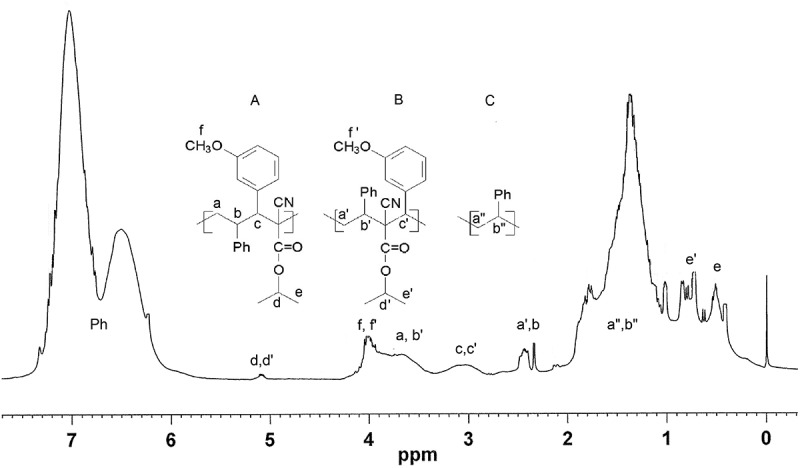
The 300 MHz 1H NMR spectrum of P(ST-co-ICPP) copolymer (R = 3-OCH3).